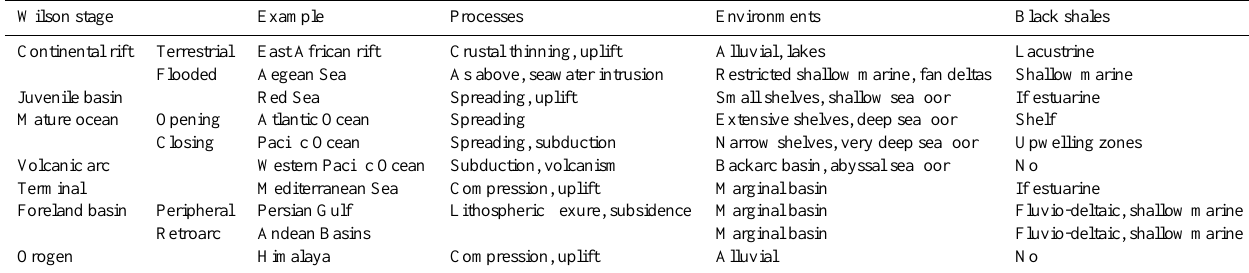
Wilson stage Example